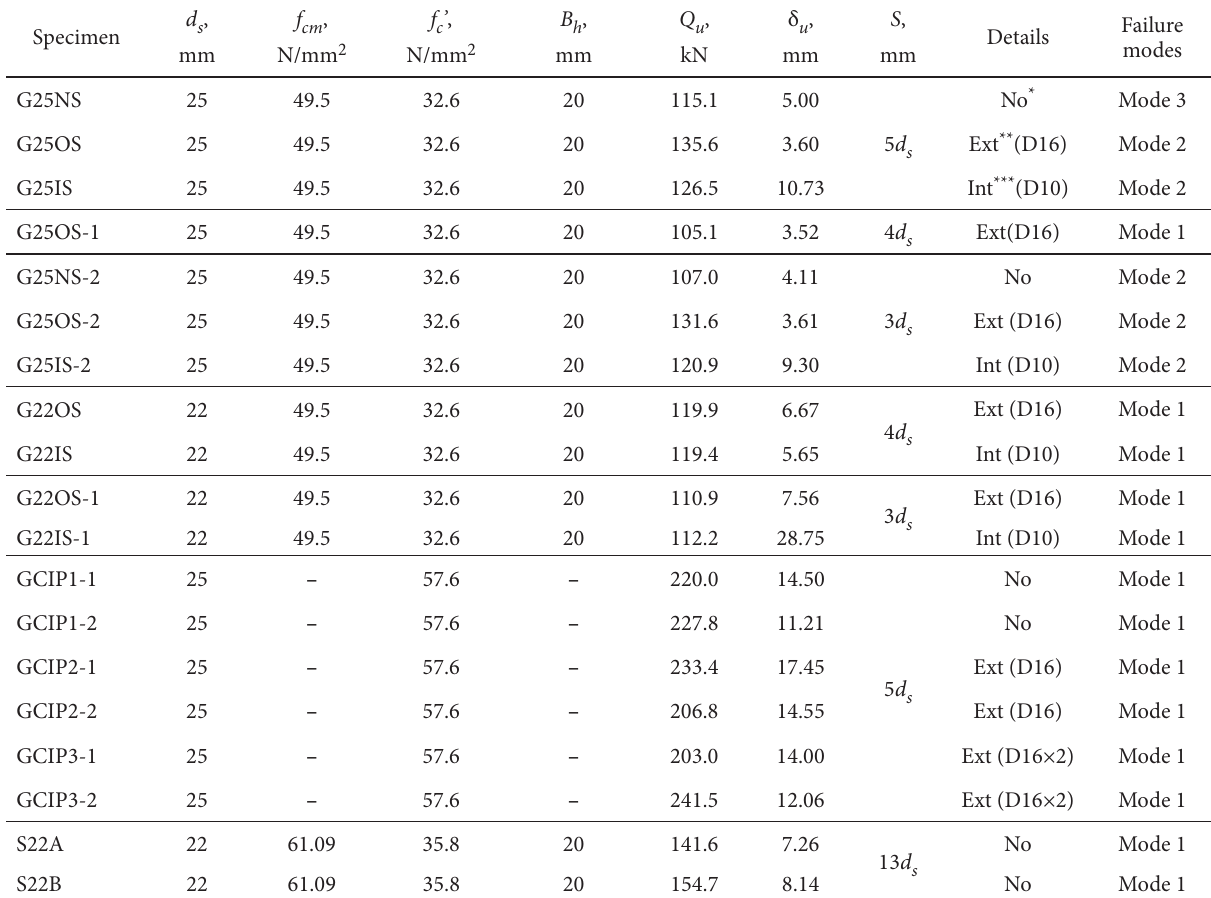
Table 1. Static test specimen for precast decks